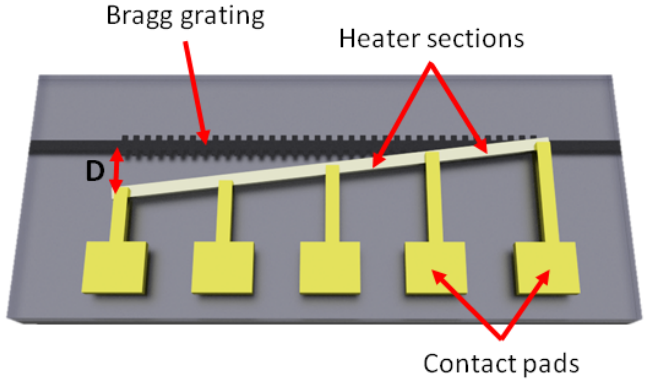
Figure 1. Schematic of a Bragg grating with an integrated heater element. The displacement between the waveguide axis and heater central position is a function of propagation length, with a maximum displacement D